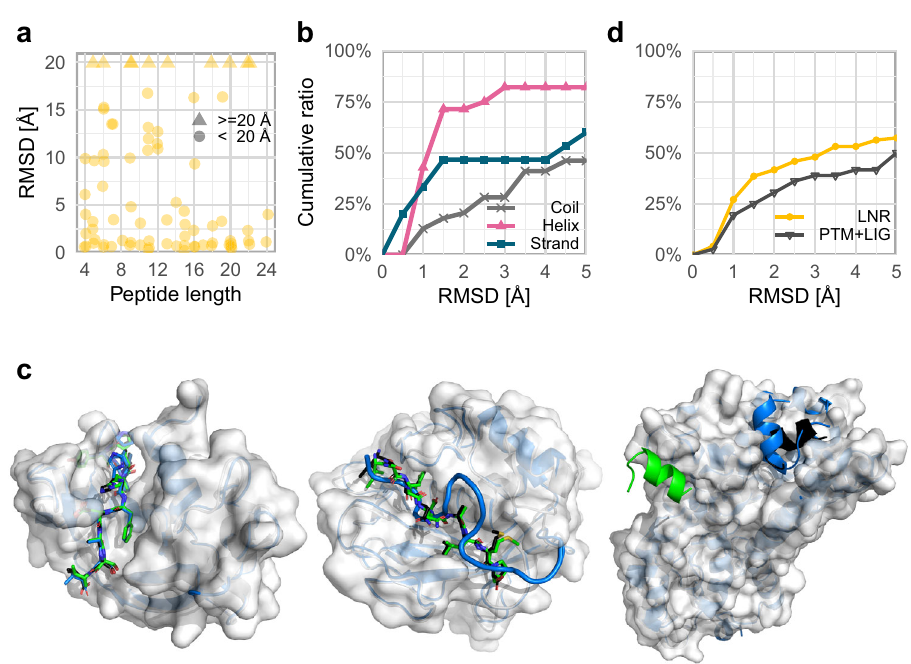
Fig. 5 Analysis of potential factors in fl uencing AF2 peptide docking performance. a Peptide length does not affect docking performance: successful models are generated for long as well as short peptides (See Supplementary Fig. 8A for the distribution of peptide lengths in the LNR dataset). Values over 20 Å are indicated by triangles. b Alpha helical peptides are modeled particularly well. Cumulative plot of performance according to the secondary structure of the peptide. (See Supplementary Fig. 8b for the corresponding distribution of secondary structures). Helical, beta strand, and coiled peptides are colored in pink, blue and gray, respectively. c Examples of potential memorization by AF2 from similar monomer structures: Left: Highly accurate prediction where a precise coverage of the structure of the peptide-receptor interface is available (native PDB ID 1ssc 70 and memorized PDB ID 1a5p 71 ). Center: Inaccurate template but successful modeling (native PDB ID 3ayu 72 and memorized PDB ID 5ue4 73 ). Right: Inaccurate template and failed model (native PDB ID 2x72 74 and memorized PDB ID 5dgy 75 ). In the latter two cases the model is most probably not built based on the inaccurate template. For all panels, the native receptor is shown in white, and native peptide in black, the memorized peptide in blue, and the modeled peptide in green. d Cumulative plot of performance on a set of peptide-receptor complex structures that were excluded due to post-translational modi fi cations or bound ligands that in fl uence the peptide structure: AF2 modeling is not dramatically impaired. The LNR set is shown in yellow, and the PTM + LIG set is shown in black. Source data are provided as a Source Data fi